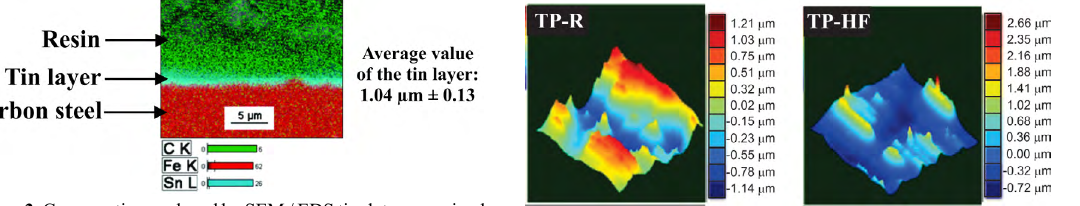
Figure 5. 3D images profilometry obtained by the samples. Table 3. Samples roughness values , determined by profilometry analysis. Sample